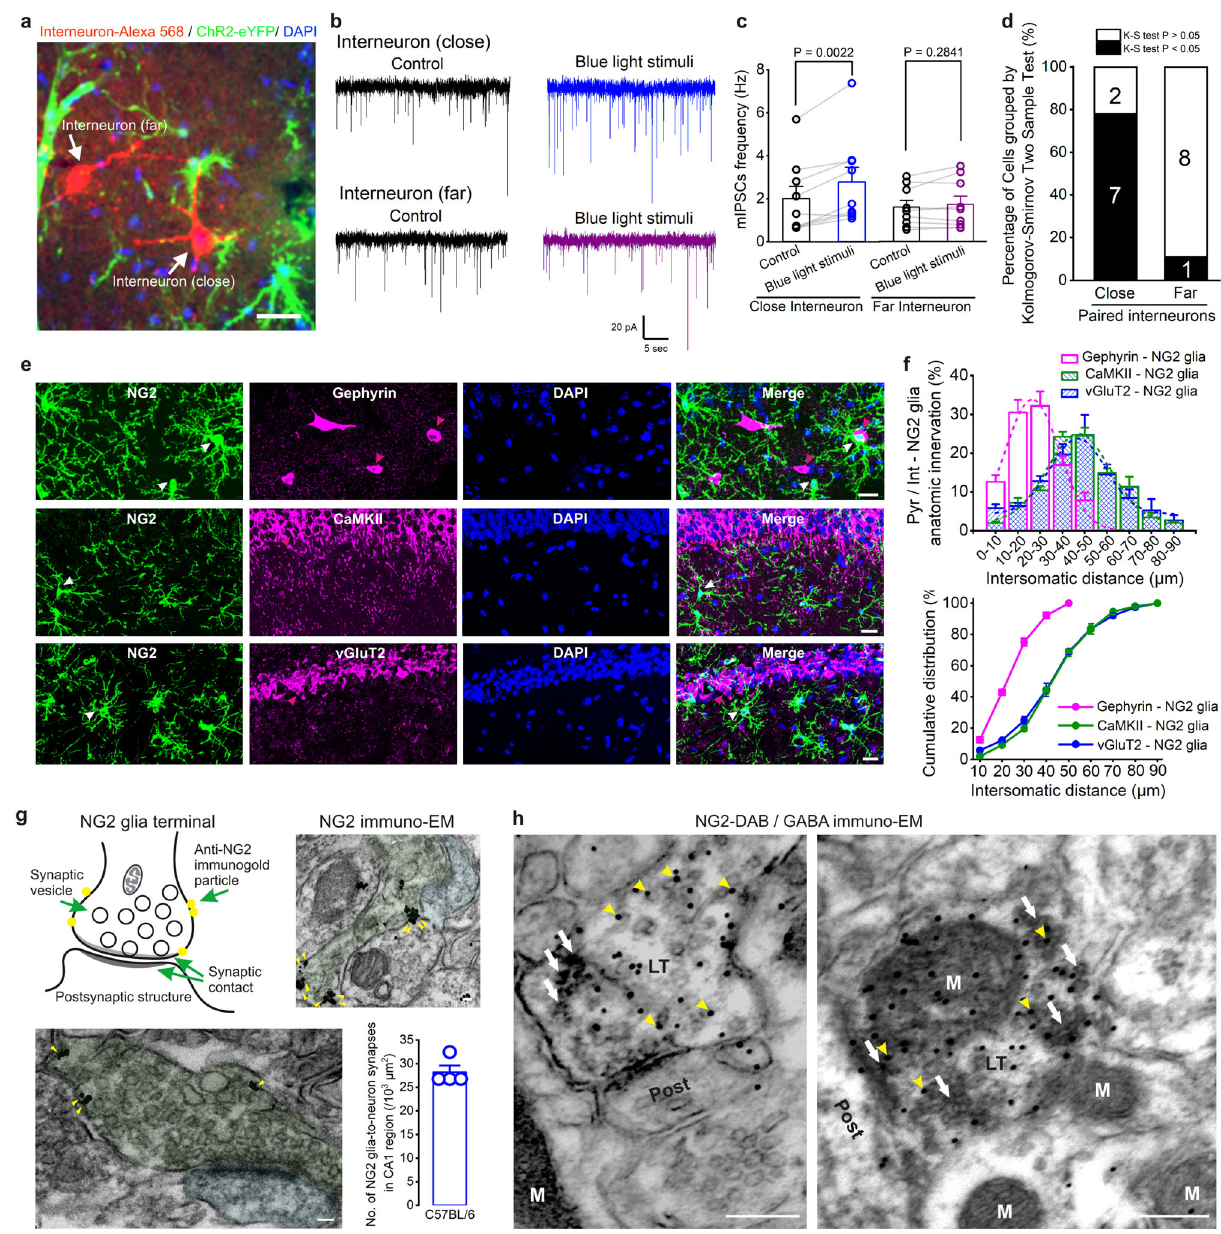
(Fig. 3e, f, n = 195 and 188 pairs for CaMKII ( + ) and vGluT2 ( +